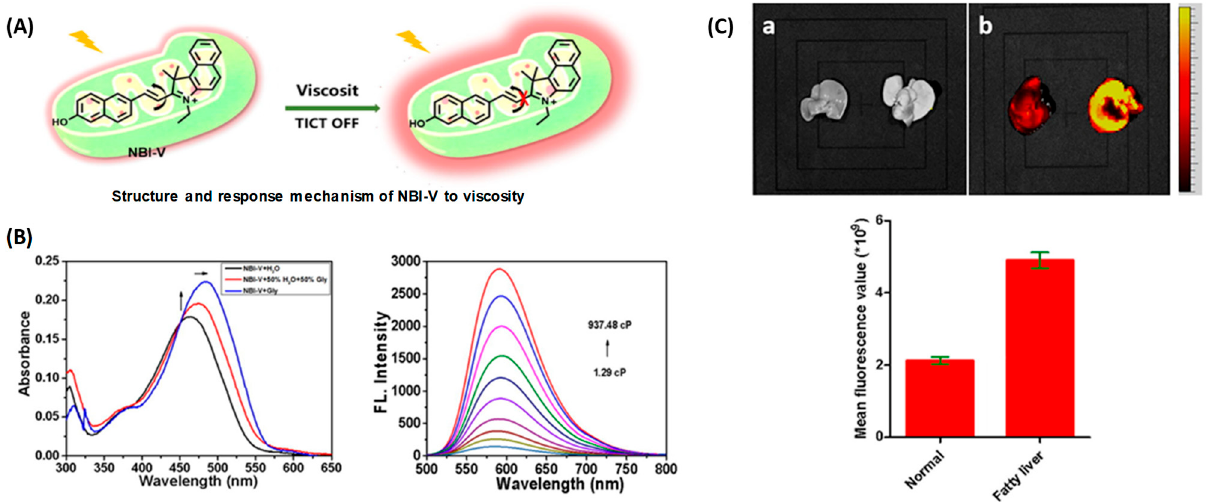
Figure 3. ( A ) The structure and reaction mechanism of probe NBI-V . ( B ) Left: Absorption spectra and Right: fluorescence spectra of probe NBI-V (10 µ M) in different ratios of water–glycerol mixtures ( λ ex = 485 nm). ( C ) Up: Fluorescence imaging of normal mice liver and fatty liver mice liver (From left to right) with NBI-V. Down: Normal mice and fatty liver mice fluorescence intensity changes of liver. [32] Copyright © 2023 Elsevier B.V. All rights reserved .